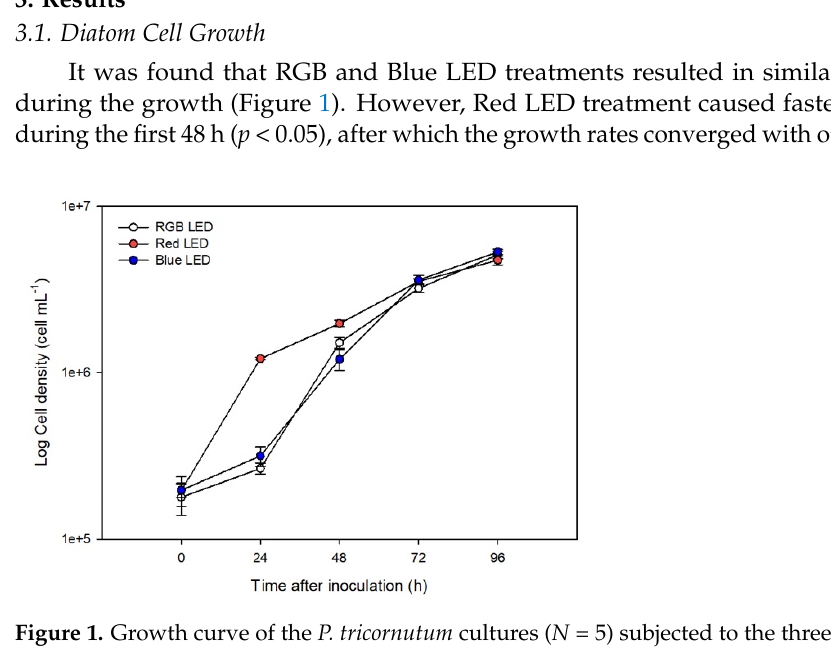
Figure 1. Growth curve of the P. tricornutum cultures ( N = 5) subjected to the three light treatments during the 96 h exposure (average ± standard error).